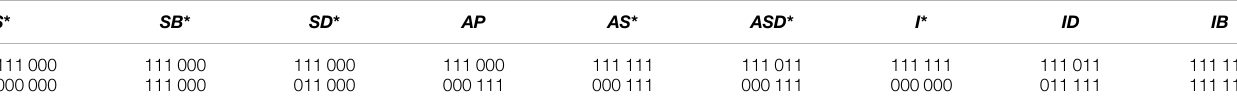
TABLE1| Matrixformofall2 TR -periodicMAINstates(*asymmetricalstateswithcoexistingconjugate).Stateswerenamedfollowingtheirproposedlinkwithperceptsinthe auditory streaming paradigm ([6]). Speci fi cally, names starting with S , I and AS represent segregation, integration and bistability, respectively. The ending letter B indicatesstatesinwhichbothunitsturnONattheonsetofthesameactivetoneinterval.Theendingletter D indicatesstatesinwhichaunitturnsONanin fi nitesimaldelayafter the other unit for at least one active tone